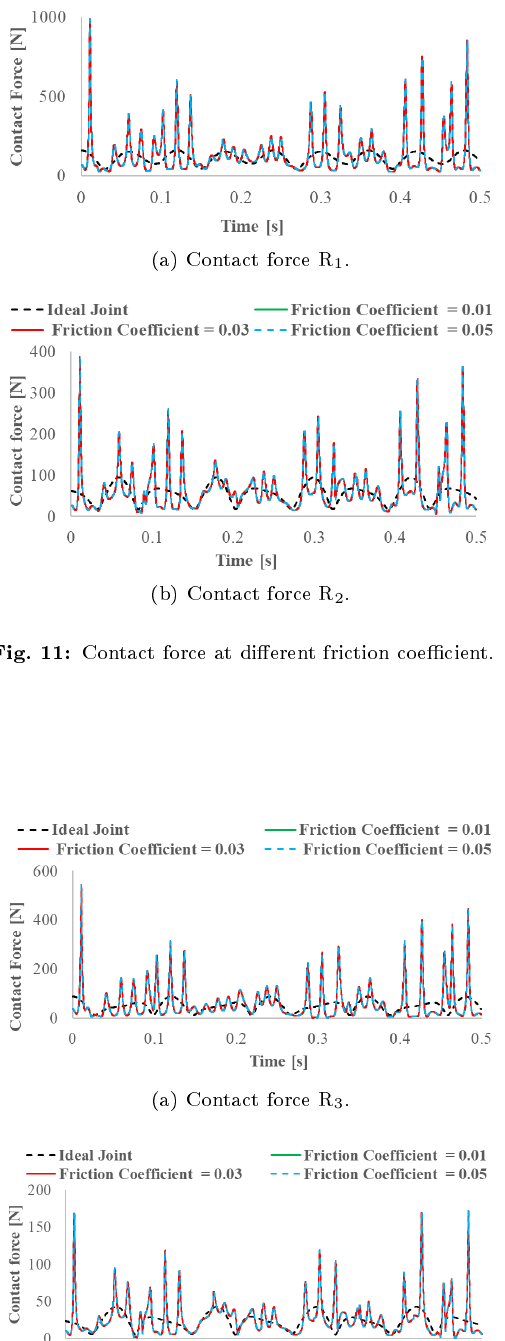
(a) Contact force R 1 .